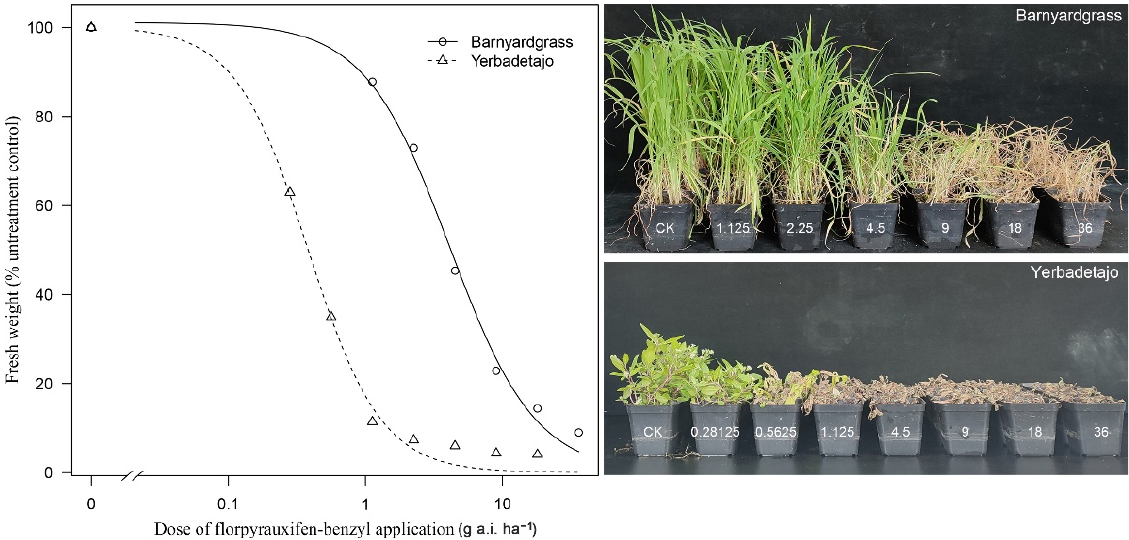
Figure 1. Dose–response analyses for response of barnyardgrass and yerbadetajo to florpyrauxifen ‐ benzyl. The X ‐ axis represents the dose (g a.i. ha − 1 ). The Y ‐ axis represents percentages of fresh weight (% untreated control).